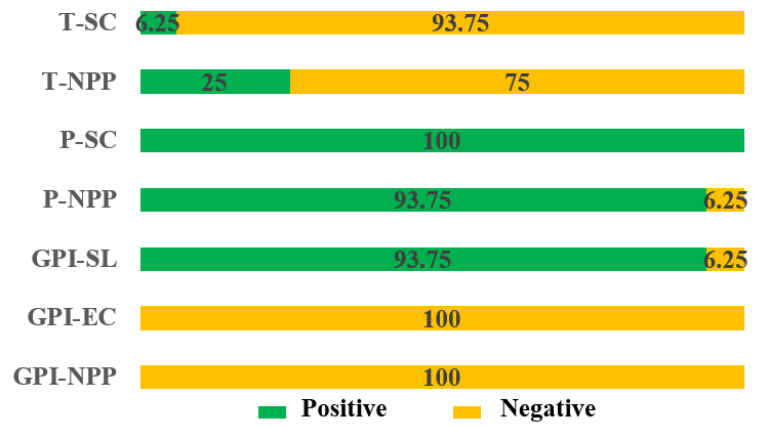
vices were very weak.